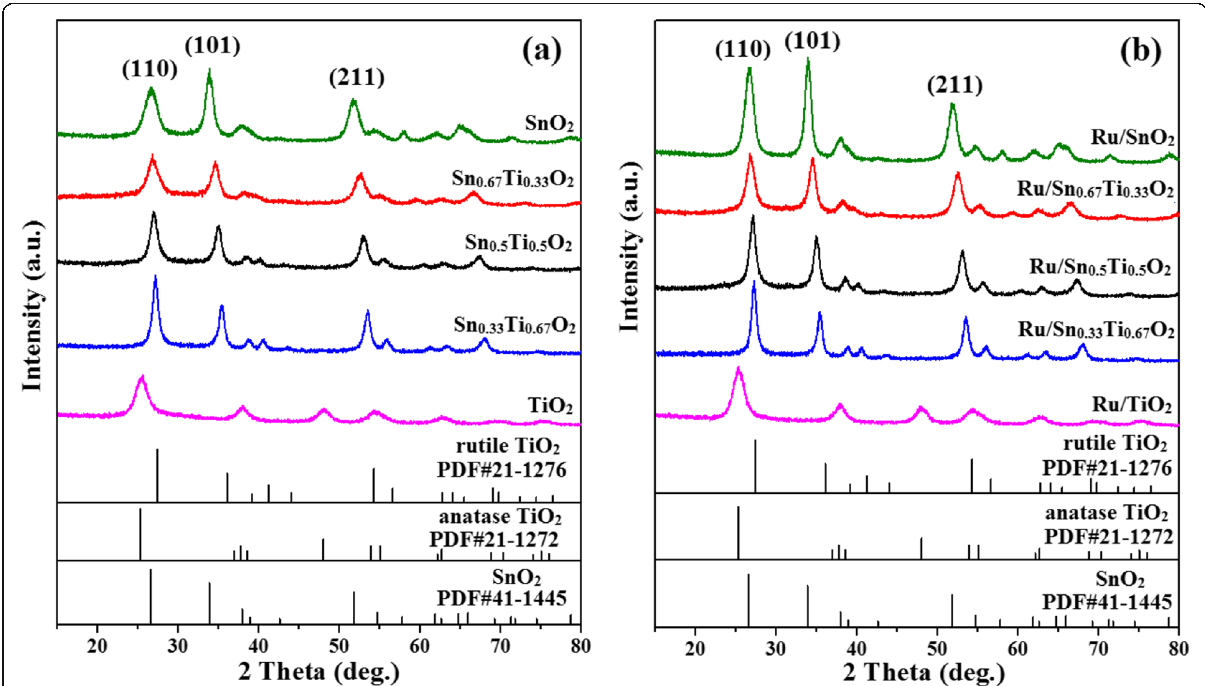
Fig. 4 XRD patterns of Sn x Ti 1 − x O 2 supports ( a ) and Ru/Sn x Ti 1 − x O 2 catalysts ( b